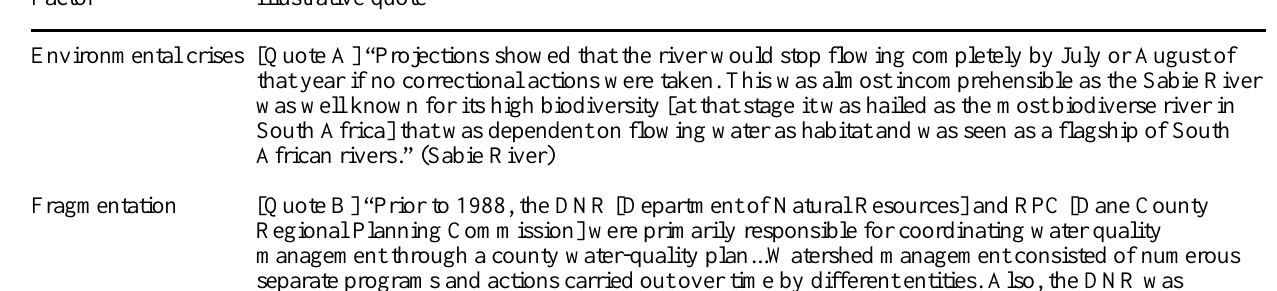
Table 3. Illustrative quotes highlighting factors facilitating transformation in the case studies.